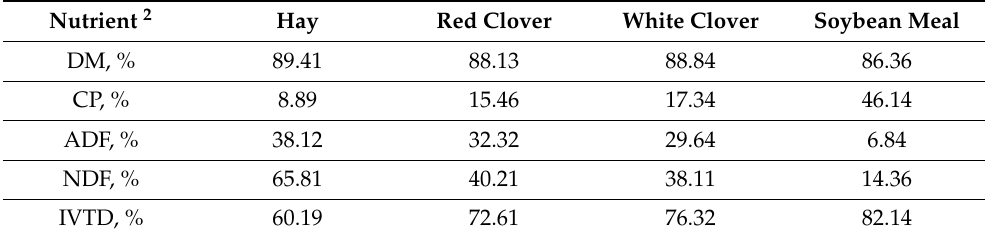
Table 1. Nutrient composition of chopped orchardgrass ( Dactylis glomerata) —timothy ( Phleum pratense ) hay, red clover, white clover, and soybean meal (dry matter basis) 1 . Nutrient 2 Hay Red Clover White